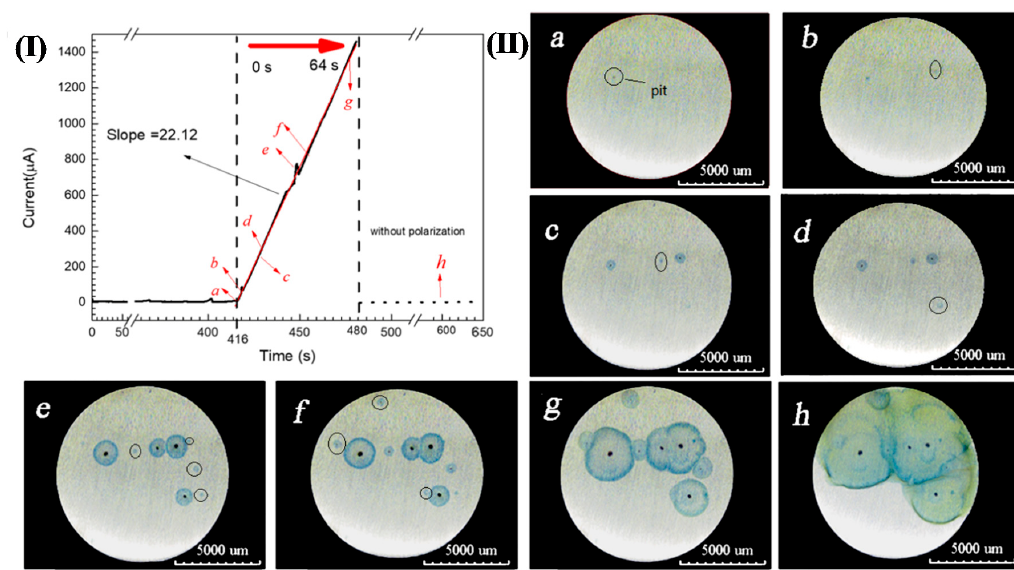
Figure 3. ( Ⅰ ) Chrono amperometry curve of 304 SS in a 3.5 wt.% NaCl and 0.05 wt.% K 4 [Fe(CN) 6 ]·3H 2 O solution at 0.35 V(SCE). ( Ⅱ ). Distribution and diffusion of pitting corrosion products over time corresponding to Figure 3( Ⅰ ): ( a ) 0 s, ( b ) 2 s, ( c ) 11 s, ( d ) 13 s, ( e ) 33 s, ( f ) 38 s, ( g ) 61 s and ( h ) 184 s.